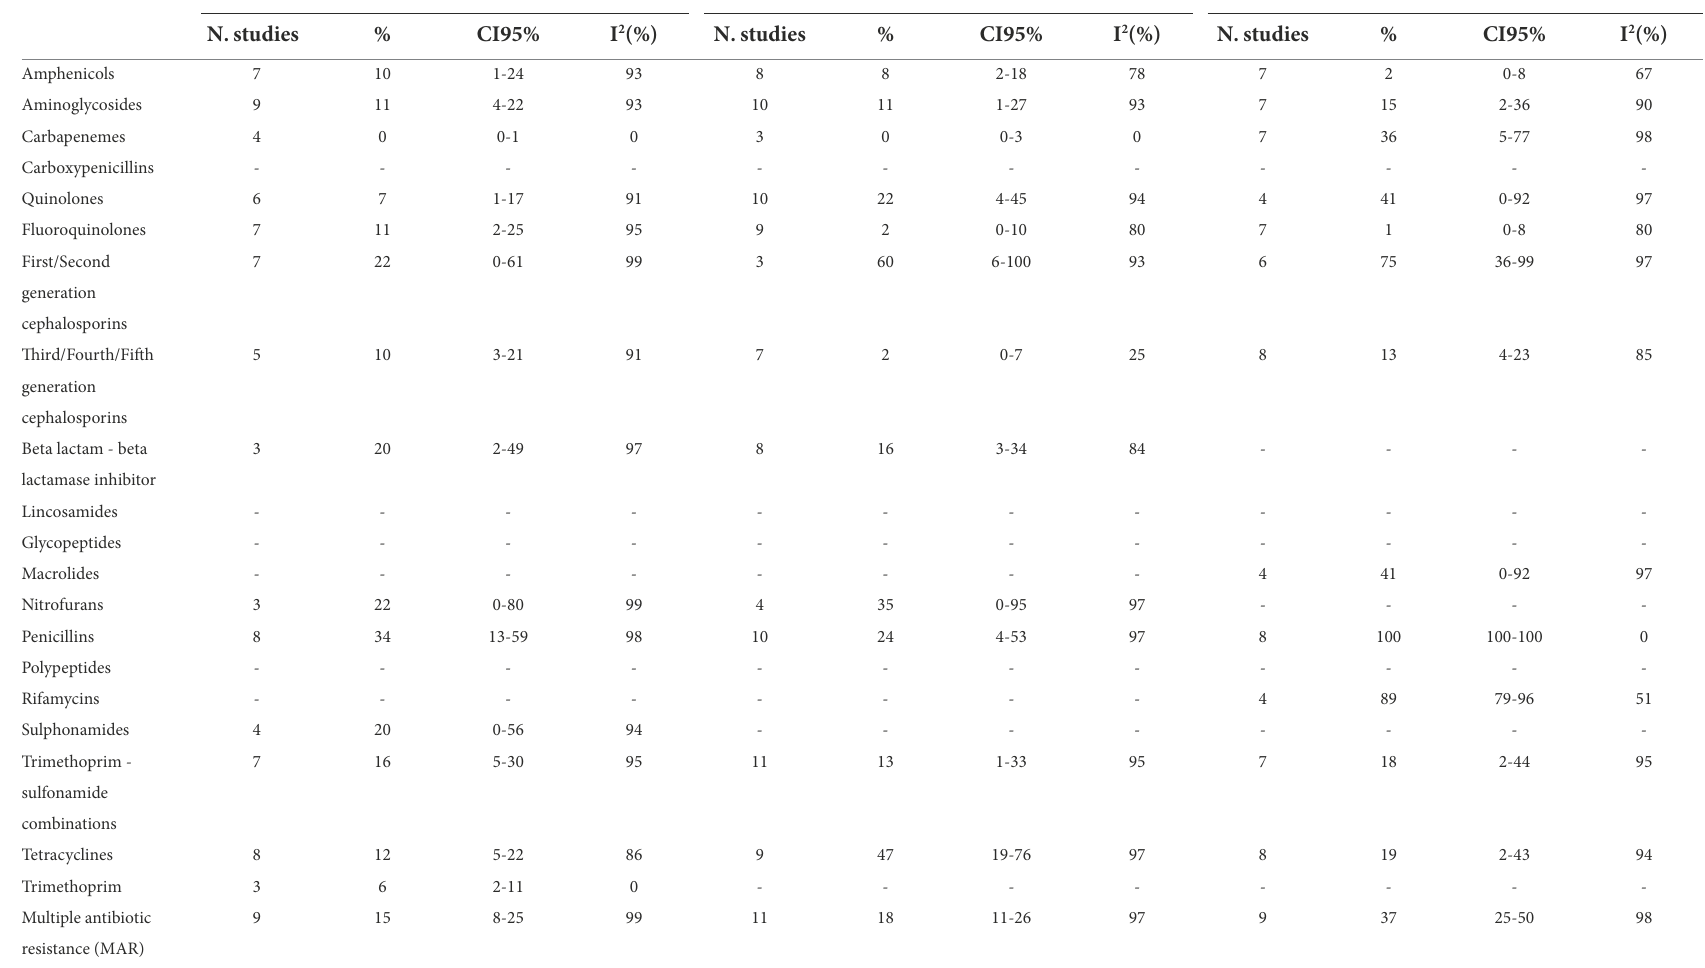
TABLE 1B Number of studies included in the meta-analysis, proportion of resistant isolates (%), 95% Confidence Interval (CI) and I 2 values for each antibiotic class. Antibiotic